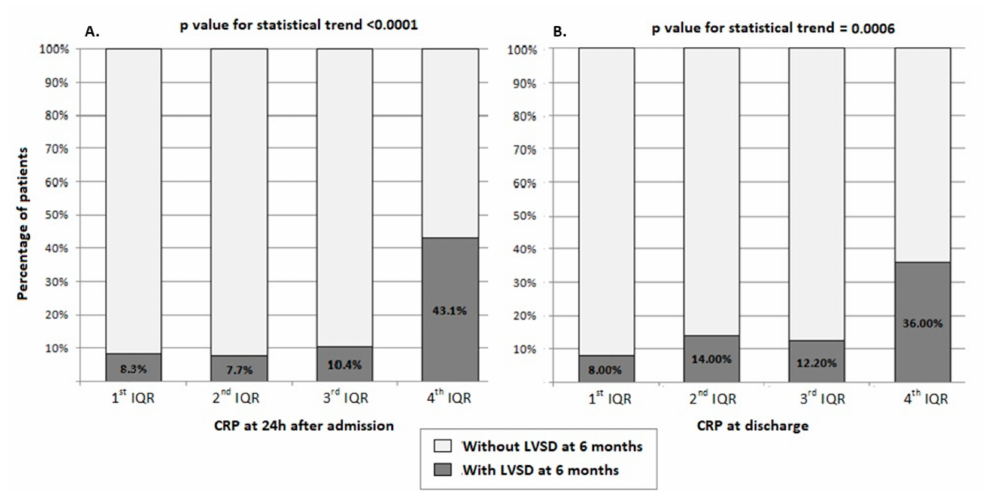
Figure 3. Prevalence of left ventricular systolic dysfunction (LVSD) 6 months after discharge post-ST-segment elevation myocardial infarction based on quartiles of C-reactive protein (CRP) concentration: ( A ) 24 h after admission ( n = 4 patients in 1st quartile, n = 4 in 2nd quartile, n = 5 in 3rd quartile, n = 22 in 4th quartile); ( B ) at discharge ( n = 4 in 1st quartile, n = 7 in 2nd quartile, n = 6 in 3rd quartile, n = 18 in 4th